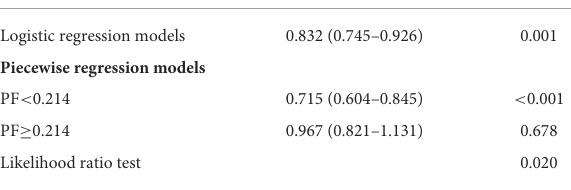
TABLE 3 Threshold effect analyzes of association between composite pulmonary function and MCI using two piecewise regression